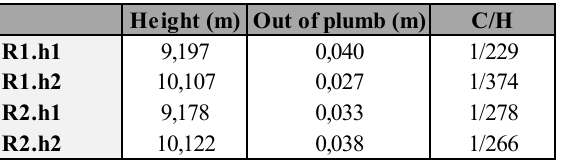
Table 3: Results of out of plumbs in buttresses.